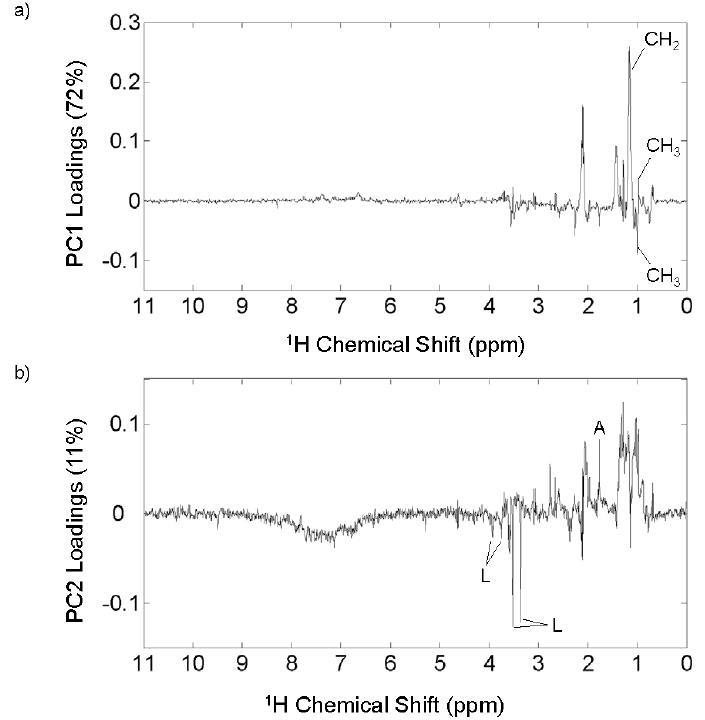
Figure 6. Variable loadings plots for ( a ) PC1 and ( b ) PC2 resulting from PCA using full 1 H NMR spectra of mixed source, biomass burning, and urban aerosol WSOM. Some peaks are labeled with the functional group region and some peaks labeled with a single letter to indicate a specific compound, where A = acetic acid or acetate and L = levoglucosan.